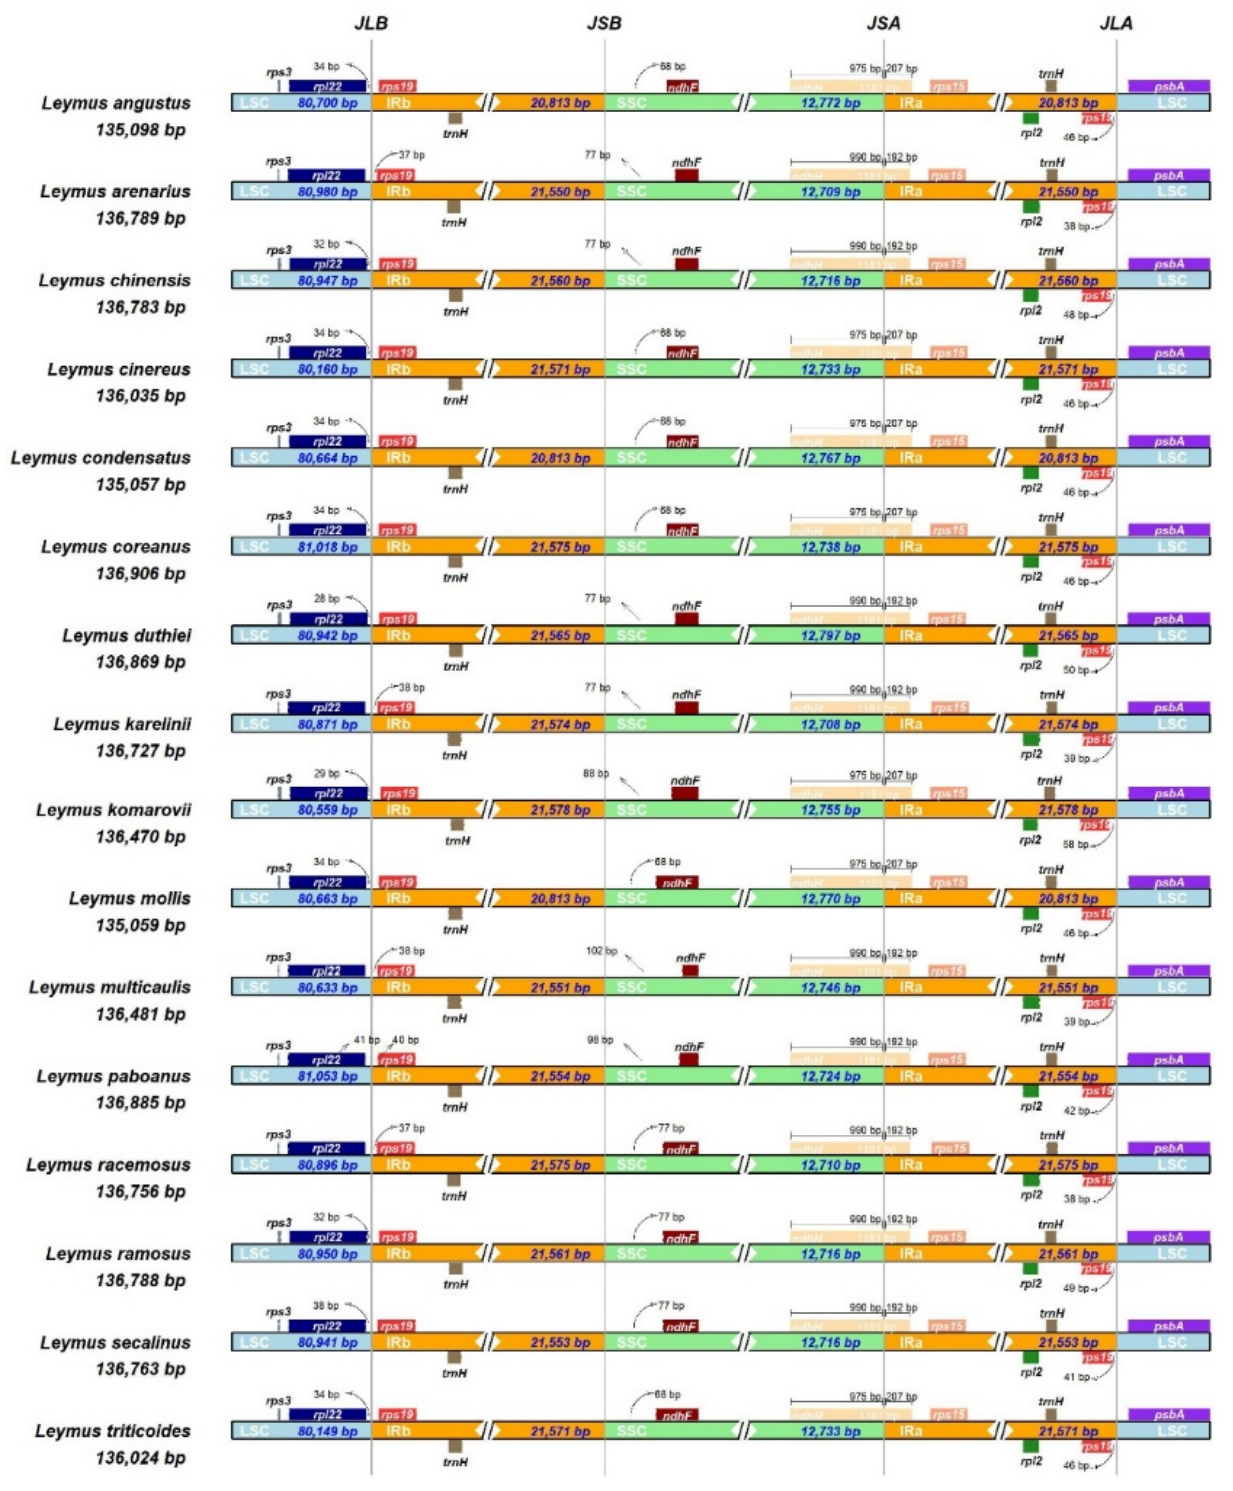
Figure 7. Comparison of the borders of the large single-copy (LSC), inverted repeat (IR), and small single-copy (SSC) junction boundaries in the cp genomes of the 16 Leymus species. JLB, JSB, JSA, and JLA represent the LSC/Irb, SSC/Irb, SSC/Ira, and LSC/Ira junction regions, respectively. 3.5. Phylogenetic Relationships between Leymus Species Using Oryza sativa and Brachypodium distachyon as outgroups, cp complete genome and 74 shared protein-coding genes were used to perform phylogenetic analysis,